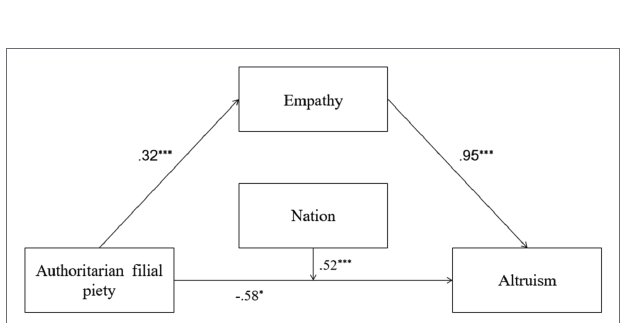
FIGURE 1 | Mediation and moderation model showing standardized coefficients (Model 1); *** p < 0.001.